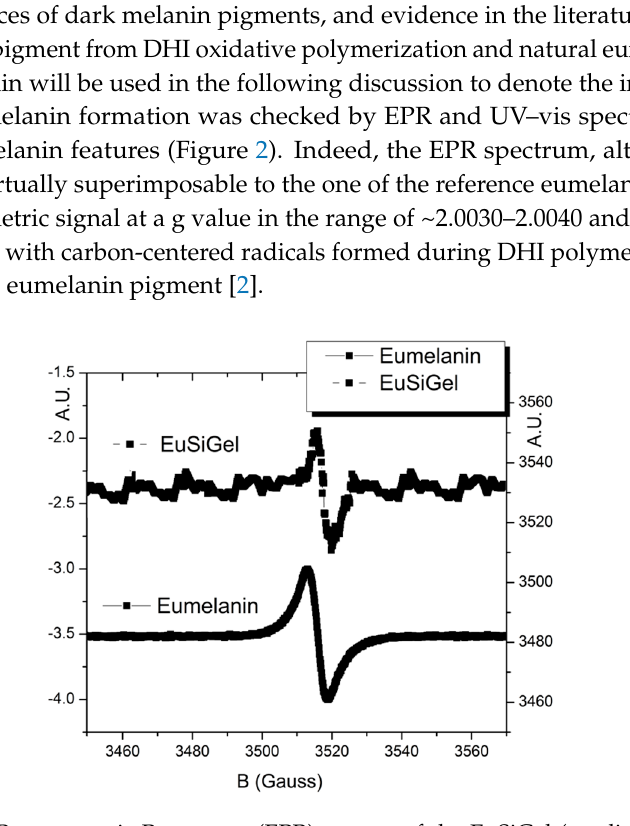
Figure 2. Electron Paramagnetic Resonance (EPR) spectra of the EuSiGel (top line) and reference eumelanin (bottom line).